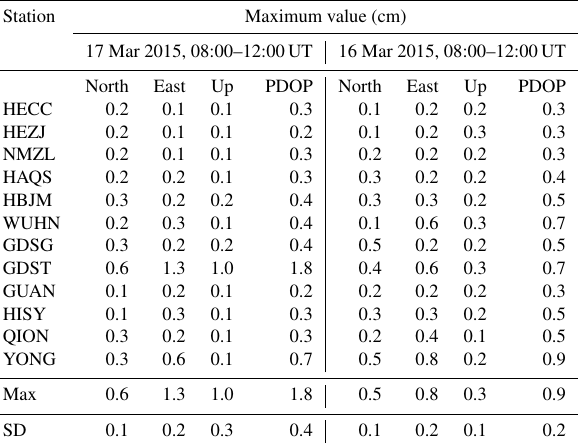
Table 2. Maximum values of NEU components from 08:00